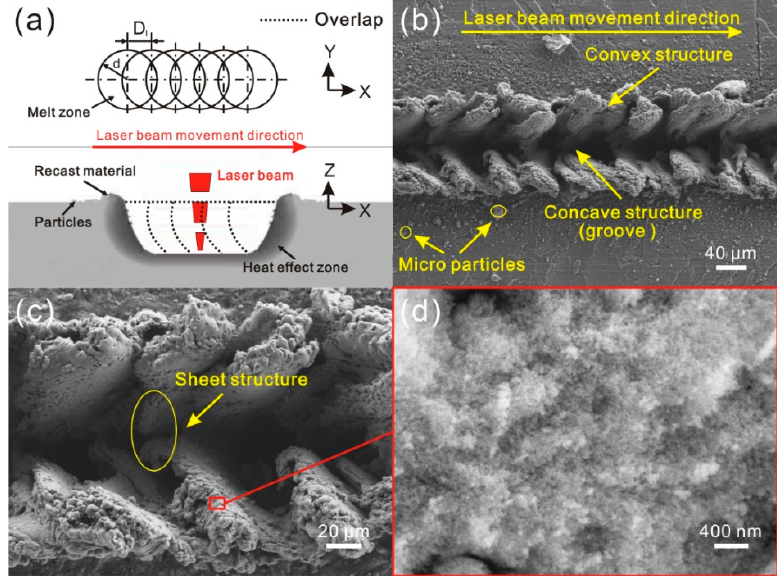
Figure 5. ( a ) Schematic of overlap degree of molten pools (multiple overlap of each melting zone, i.e., 0 < D 1 < d/2); ( b ) SEM image of the microstructure on Al alloy surface (laser beam pulse frequency of 6000 Hz, laser beam scanning speed of 0.15 m/s); ( c , d ) high-magnification SEM image of the Al alloy surface.